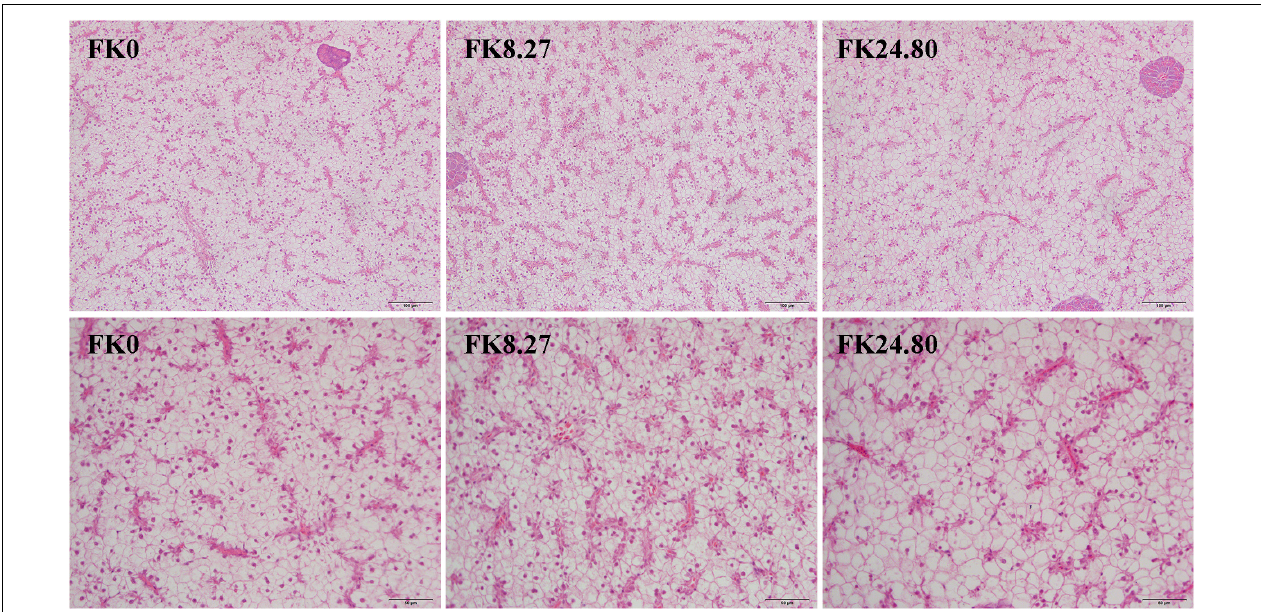
FIGURE 2 | Representative histomorphological images from hematoxylin and eosin-stained liver of black sea bream fed FK0, FK8.27, and FK24.80 diets for 10 weeks (200 × /400 × ).